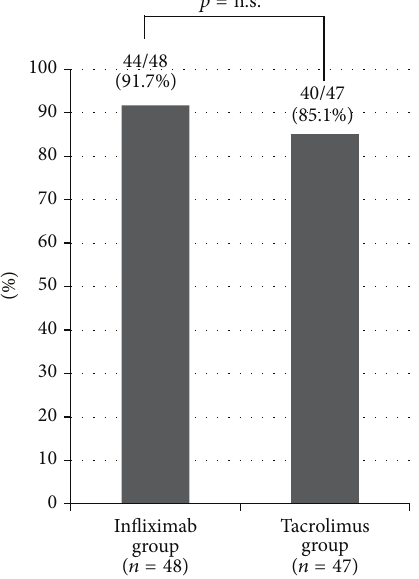
Figure 2: Colectomy-free rate at 2 months. Colectomy-free rate at 2 months was 91.7% in the infliximab group and 85.1% in the tacrolimus group, without a significant difference between the two